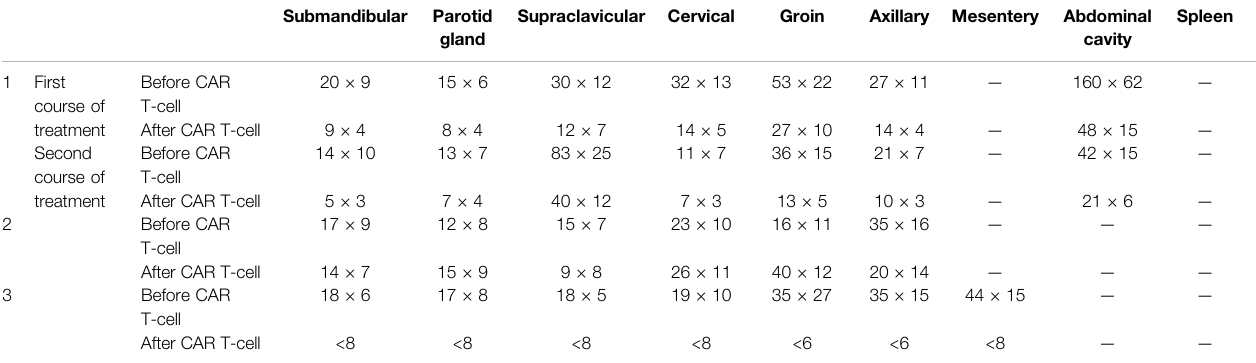
TABLE 2 | Value of measurable lymph nodes, extranodal lesions, and spleen (CT)